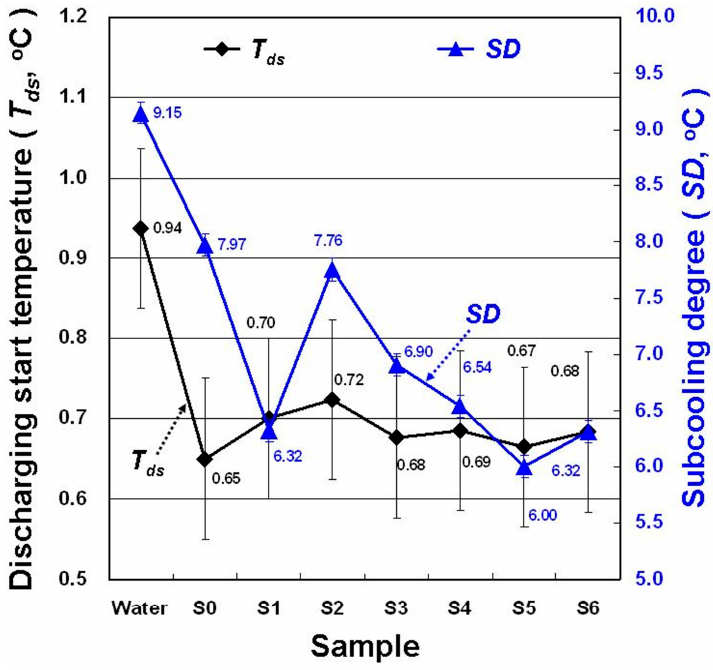
Figure 8. Changes in T ds and subcooling degree ( SD) for the